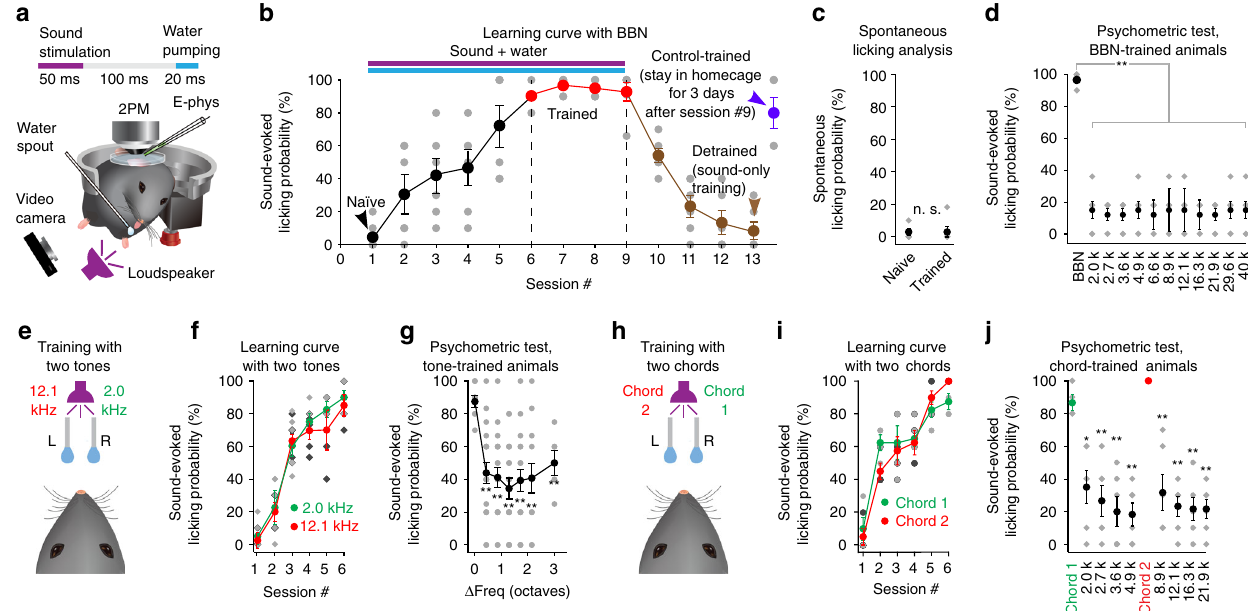
Fig. 1 An auditory association training paradigm. a Cartoon illustration of the sound-water association training paradigm and experiment setup. 2PM: two-photon microscope; E-phys: single-cell loose-patch pipette. b Learning curve, animals trained and tested with broadband noise (BBN), n = 6 mice. Error bars: + / − s.e.m., same for all the other panels in Fig. 1. c Spontaneous licking analysis. n.s., P > 0.05. n = 6 mice. d Psychometric test in animals trained with BBN and tested with a range of pure tones; P = 3.30e − 3, P = 3.30e − 3 , P = 3.30e − 3 , P = 5.50e − 3, P = 1.10e − 3 , P = 3.30e − 3 , P = 2.20e − 3, P = 6 mice. e Cartoon illustration of the 2-tone training paradigm. f Learning curve, animals trained with 2 tones (2.0 kHz or 12.1 kHz), n = 6 mice. g Psychometric test, 2-tone-trained animals, Δ Freq (octaves): frequency difference between the test tone and one of the two trained tones (to the closer one); P = 4.20e − 3 , P = 3.00e − 3, P = 6.00e − 4 , P = 3.00e − 3, P = 7.80e − 3 , P = 9.00e − 3, two-sided unpaired bootstrap test, the test tone versus other tones, respectively, Bonferroni corrected, n = 6 mice. h Cartoon illustration of the 2-chord training paradigm. i Learning curve, animals trained with 2 chords; n = 6 mice. j Psychometric test, 2-tone-trained animals tested with the two trained chords and each of their constituent tones; P = 0.0128, P = 6.00e − 3 , P = 5.20e − 3 , P = 3.20e − 3, chord 1 versus its constituent tones, respectively, two-sided paired bootstrap test, Bonferroni corrected, n = 6 mice; P = 5.60e − 3 , P = 1.20e − 3, P = 1.20e − 3 , P = 8.00e − 4, chord 2 versus its constituent tones, respectively, two-sided paired bootstrap test, Bonferroni corrected, n = 6 mice. In psychometric testing sessions, different sounds were played in randomized trial orders, and behavioural responses until a total consumption of 20 droplets in one session were used for analysis. Data with error bars are presented as the mean ± s.e.m. ** P < 0.01, * P <